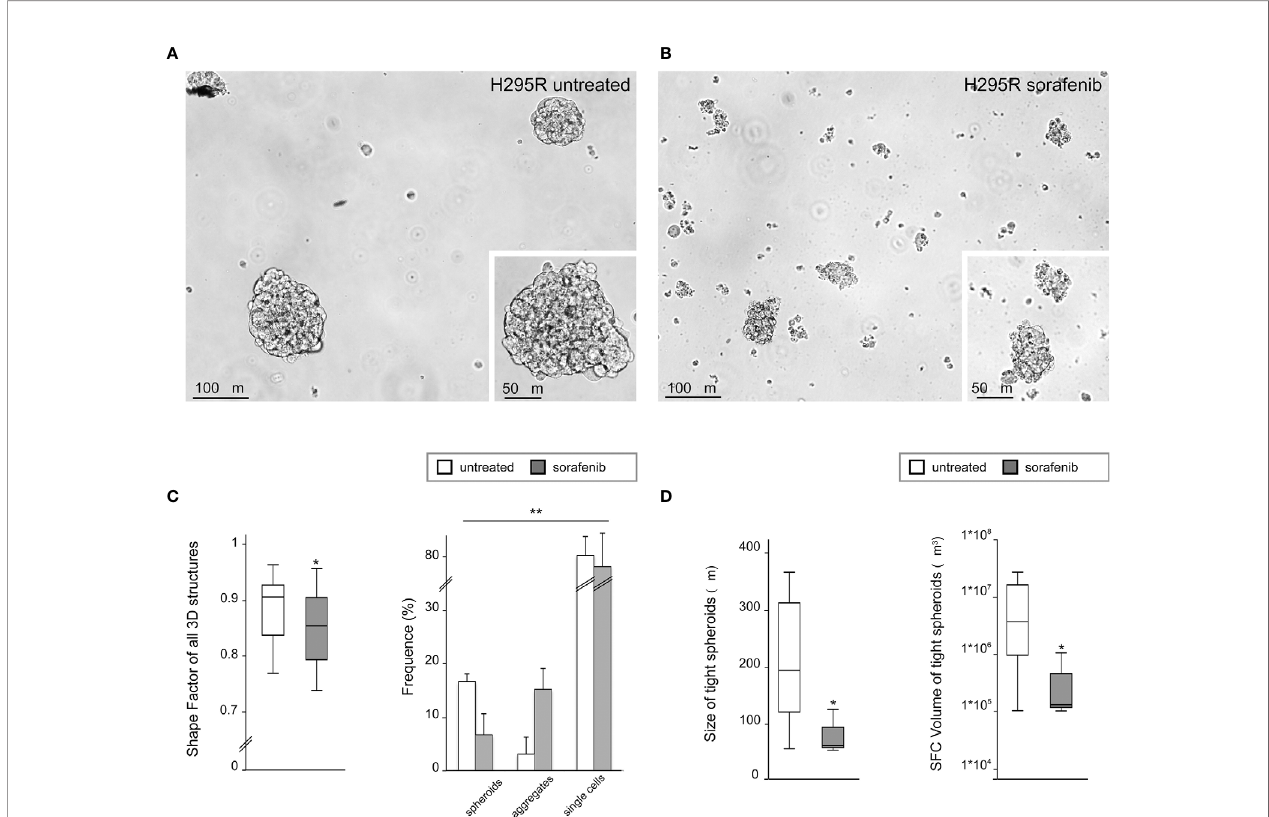
FIGURE 3 | Three-dimensional and morphometric analysis of H295R spheroid growth in sphere medium with or without sorafenib. Differential interference contrast microscopy of H295R cell cultures: typical spheroid pattern of growth in untreated H295R cultures (A) and multicellular aggregates in H295R cultures cell growth treated with sorafenib (B) . Morphometric analysis of all multicellular structures from treated or untreated H295R cells: the box-and-whisker plot of shape factor shows a higher sphericity index for the spheroids derived from H295R untreated cultures (control) than for those from the treated cultures. The central box represents the interquartile ranges, the middle line represents the median and the horizontal lines represent the minimum and the maximum value of the observation range (Mann-Whitney test: *p<0.001). The results reported in the graph represent the mean values ± standard error (chi-squared test: **p<0.01) (C) . Morphometric analysis of tight spheroids from treated or untreated H295R cells: the box-and-whisker plots of size and SFC volume show a signi fi cant difference in untreated and treated cultures H295R cells (Mann-Whitney test: *p<0.001) (D)